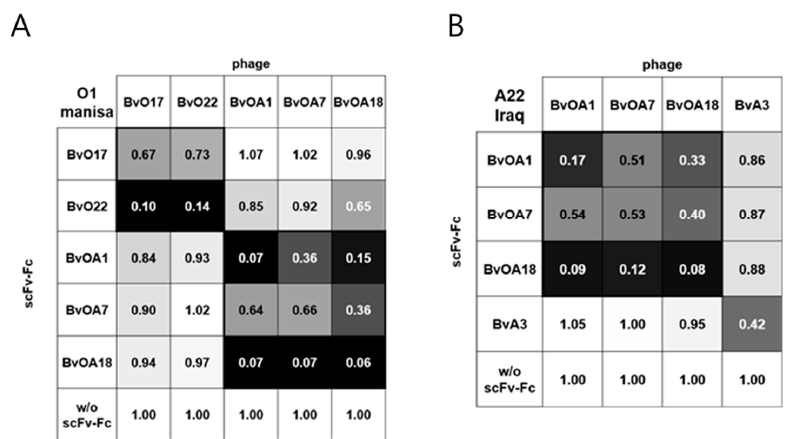
Figure 3. Epitope binning of bovine scFvs by cross-competition ELISA. Inactivated FMDV type